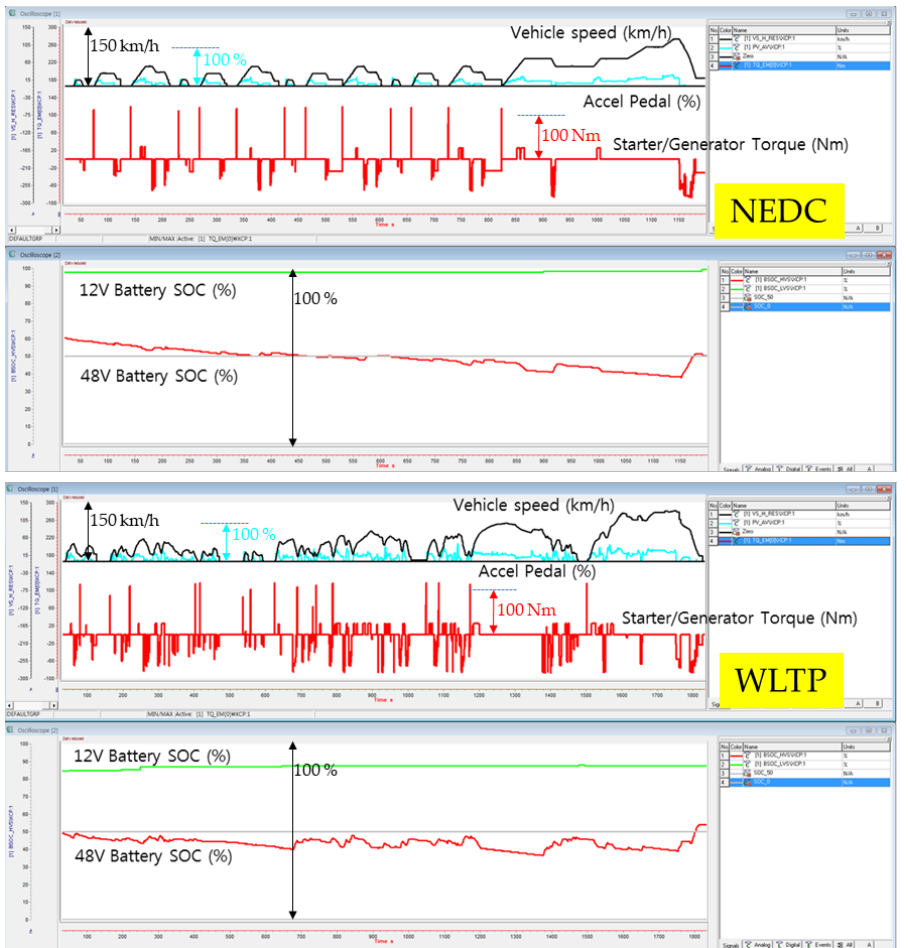
Figure 24. Torque control of the 48-V motor/generator in NEDC and WLTP modes (Top: NEDC, Bottom: WLTP).